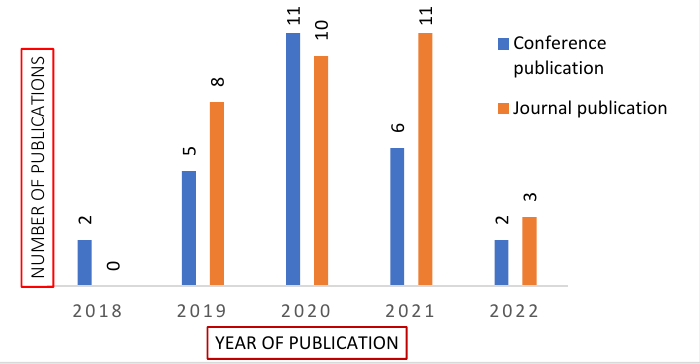
Figure 2. Selected article distribution .